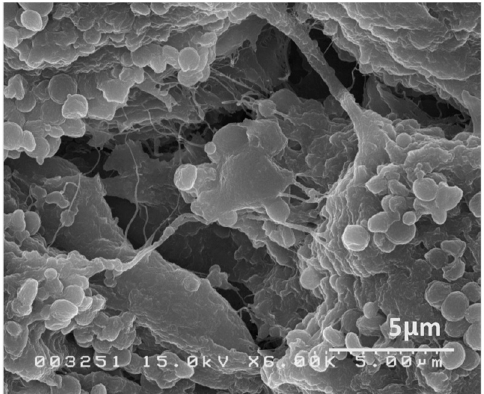
Figure 1. Scanning electron microscopy images of extracellular vesicles (EVs) released from cardiomyocytes. Cardiac tissues from a healthy mouse were collected and prepared (primary fixation with 2.5% glutaraldehyde, secondary fixation with osmium tetroxide, dehydration, mounting, and ion sputter coating). The sample was observed by scanning electron microscope (Hitachi S-4500). [Unpublished